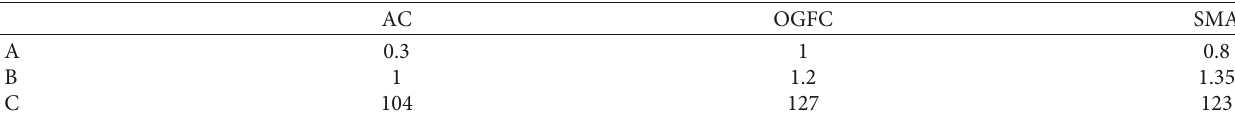
Figure 9: Partial measured value of contact stress. Table 11: Values of